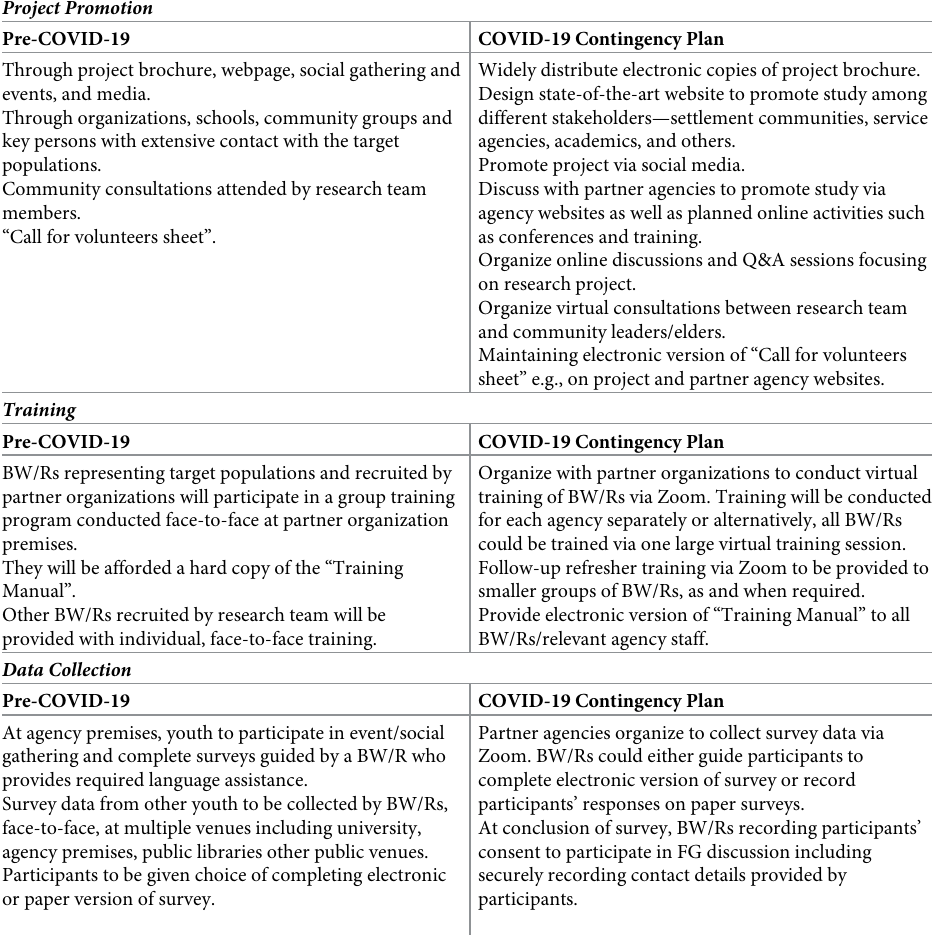
Table 2. COVID-19 Contingency plan when face-to-face interaction is not possible. Project